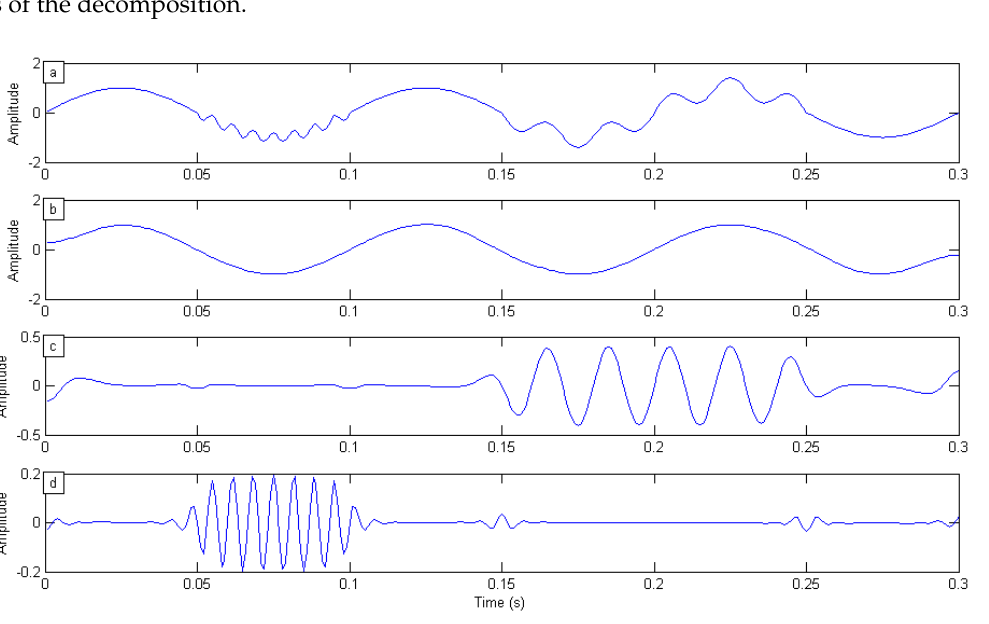
Figure 3. Synthetic signal and intrinsic mode function (IMF): ( a ) signal s; ( b ) the first IMF; ( c ) the second IMF; and, ( d ) the third IMF. second IMF; and, ( d ) the third